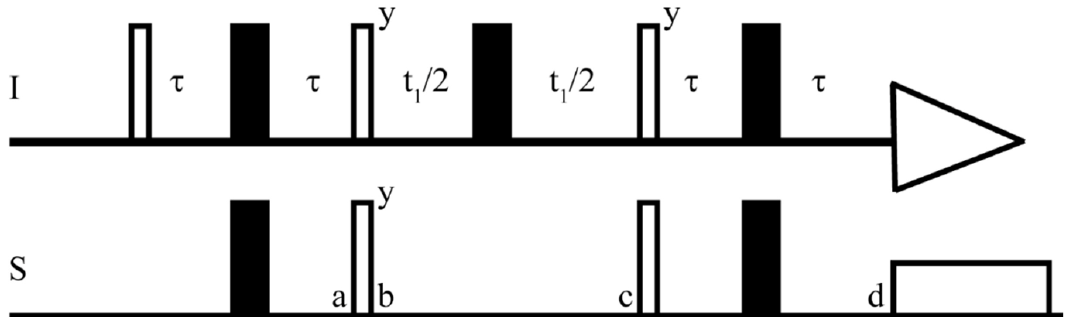
Figure 3. The pulse sequence of HSQC. I and S represent two heteronuclear spins. The τ is (1/4J) where J is the coupling constant. The thick and thin bars represent the 180° and 90° pulse respectively [142].